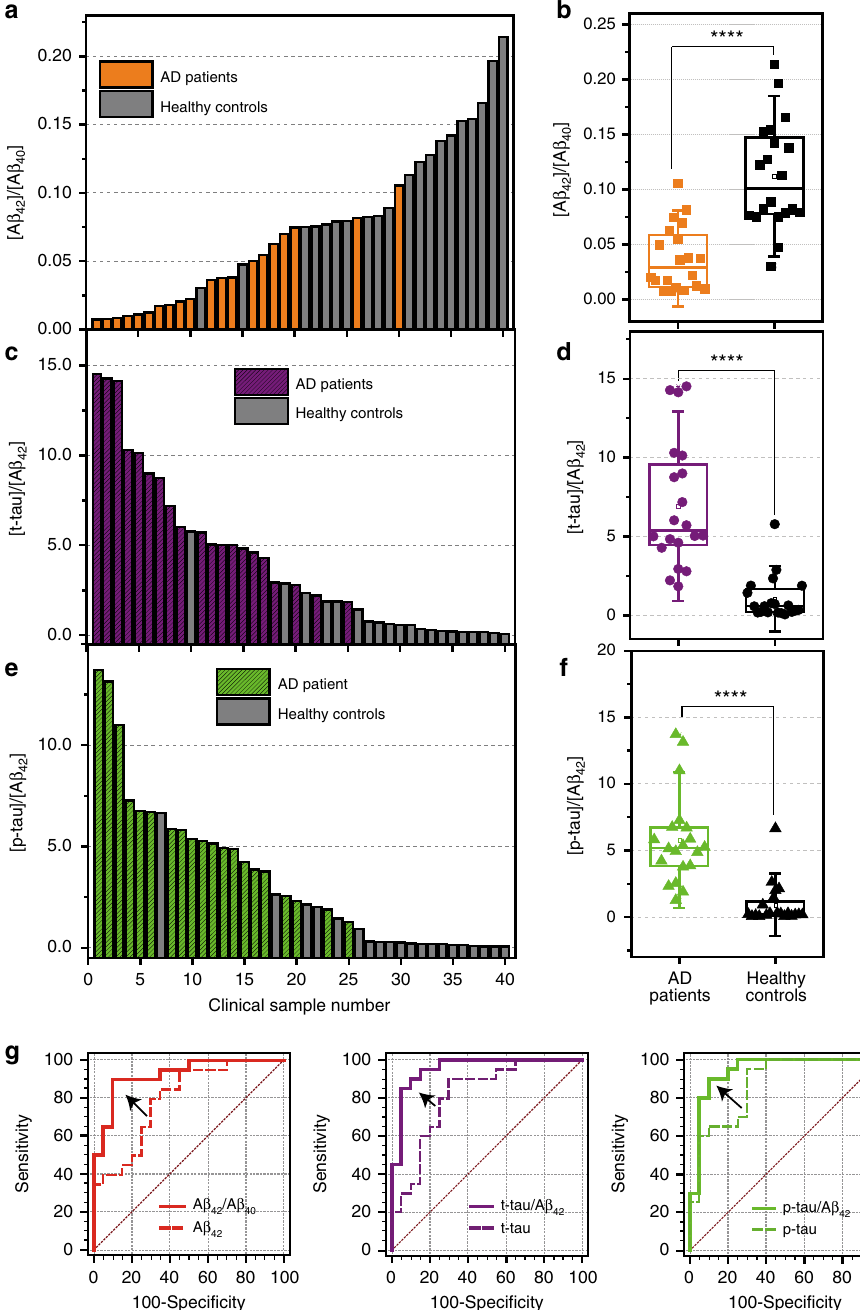
Fig. 4 Clinical relevance of the densely aligned CNT sensor array. Waterfall plots and box plots showing the estimated levels of ( a , b ) A β 42 /A β 40 , ( c , d ) t- tau/A β 42 , and ( e , f ) p-tau/A β 42 in the plasma of AD patients ( n = 20) and healthy controls ( n = 20). Statistical analysis was carried out by means of one- way analysis of variance (ANOVA). **** p < 0.000001. In the boxes, the 25th, 50th (median), and 75th percentiles of the data are indicated. The whiskers represent mean ± 1.5 SD. g Receiver operating characteristic curves of the sensor array when composite biomarkers (A β 42 /A β 40 , t-tau/A β 42 , and p-tau/ A β 42 ) and single biomarker (A β 42 , t-tau, p-tau) were used as a predictor, respectively. Source data are provided as a Source Data fi